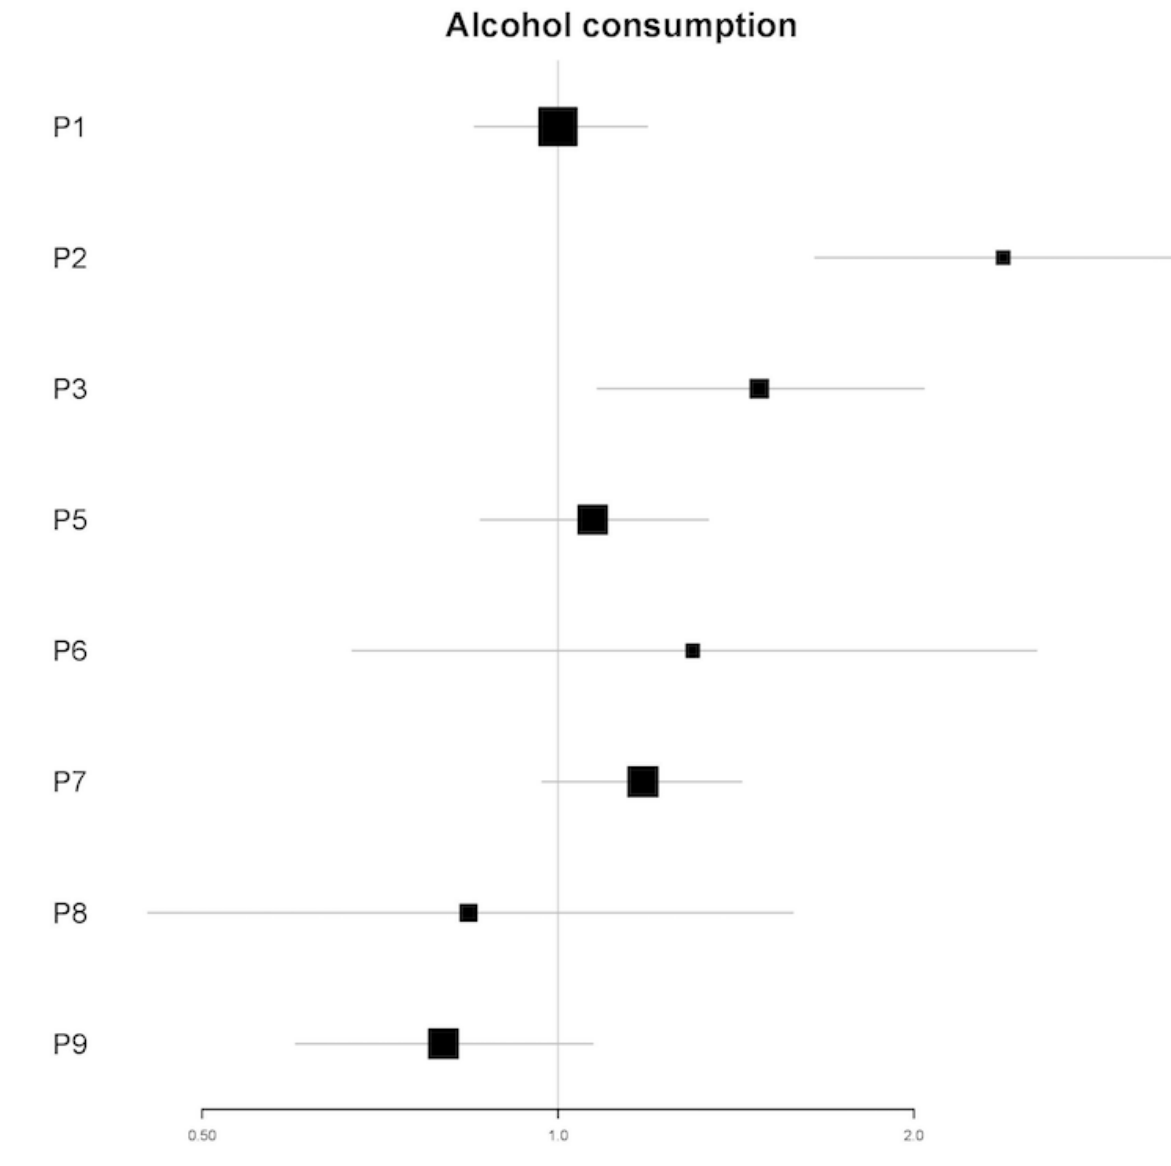
Figure 8. Plot of incidence rate ratios and 95% CIs (x-axis) for the association of alcohol consumption and the amount of engagement for each